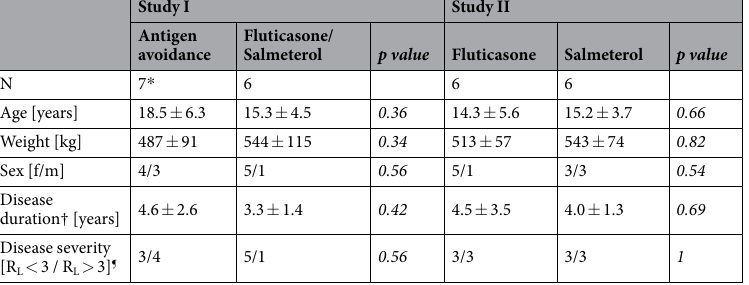
Table 1. Horses’ description. Eight months elapsed between study I and II. Seven out of 17 horses participated in both studies, equally distributed between groups. * One horse in the antigen avoidance group underwent all sampling except peripheral lung biopsies. † For horses with unknown history, disease duration was estimated as starting one year before the moment they joined the research herd, a possible underestimation. ¶ Disease severity was determined based on the horse clinical history and lung function data, with horses reaching at least once in the observation period in our research herd prior or during the study a respiratory resistance (R L ) > 3 cmH 2 O/L/sec during disease exacerbations classed as those with increased disease